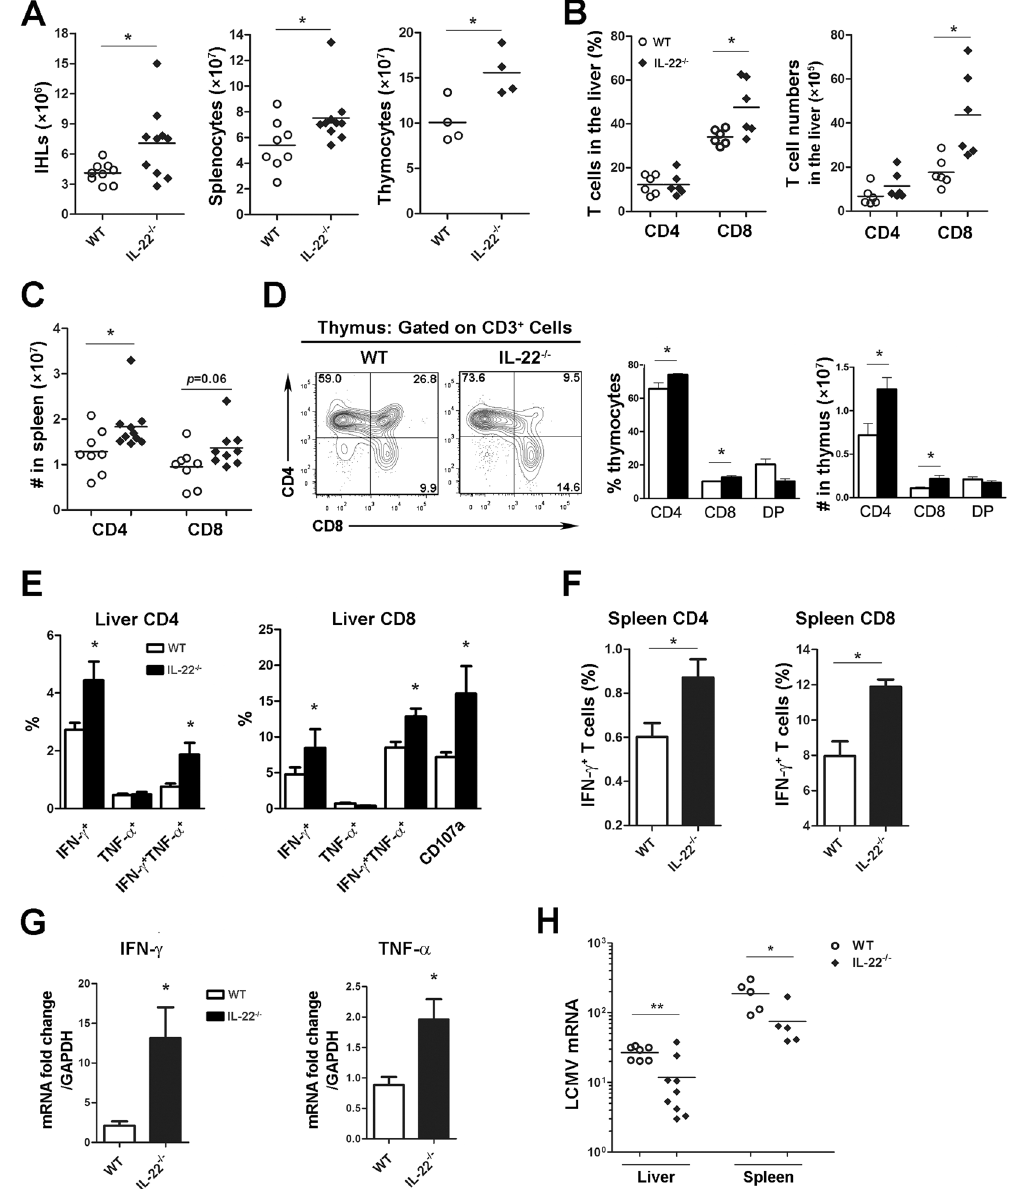
Figure 7. IL-22 deficiency sustains T cell responses in persistent viral infection. WT and IL - 22 − / − mice were infected with Clone 13 (2 × 10 6 pfu/mouse) for 60 days. ( A ) The total number of leukocytes in the liver, spleen and thymus were counted. ( B ) Percentage and number of CD4 + and CD8 + T cells in the liver were analyzed with flow cytometry. ( C ) The number of CD4 + and CD8 + T cells in the spleen was determined. ( D ) Percentage and number of CD4 + , CD8 + and double-positive T cells in the thymus were analyzed with flow cytometry. ( E and F ) Leukocytes were isolated and incubated with LCMV peptide GP 61 or GP 33 for 5 h. Cytokine production in viral-specific T cells in the liver ( E ) and spleen ( F ) were measured by flow cytometry. IFN - γ and TNF - α gene expression in the liver ( G ) and LCMV mRNA in the liver and spleen tissues ( H ) were detected by qPCR. Data are representative of at least two independent experiments. The results are expressed as the mean ± SEM ( n = 6–10). * p <